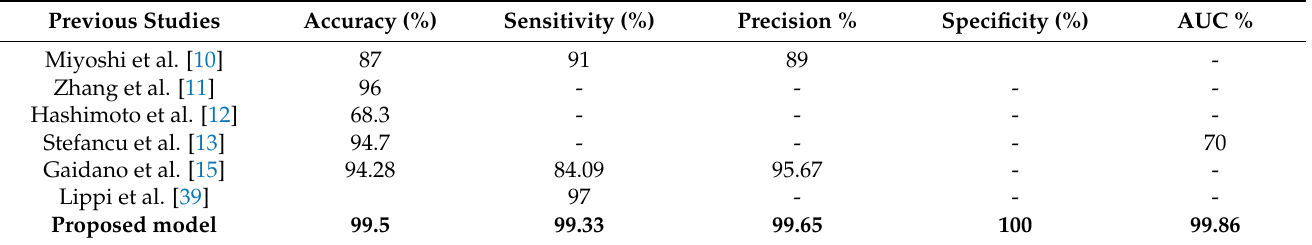
Table 6. A comparison of the performance of the proposed systems with the performance of the systems from previous relevant